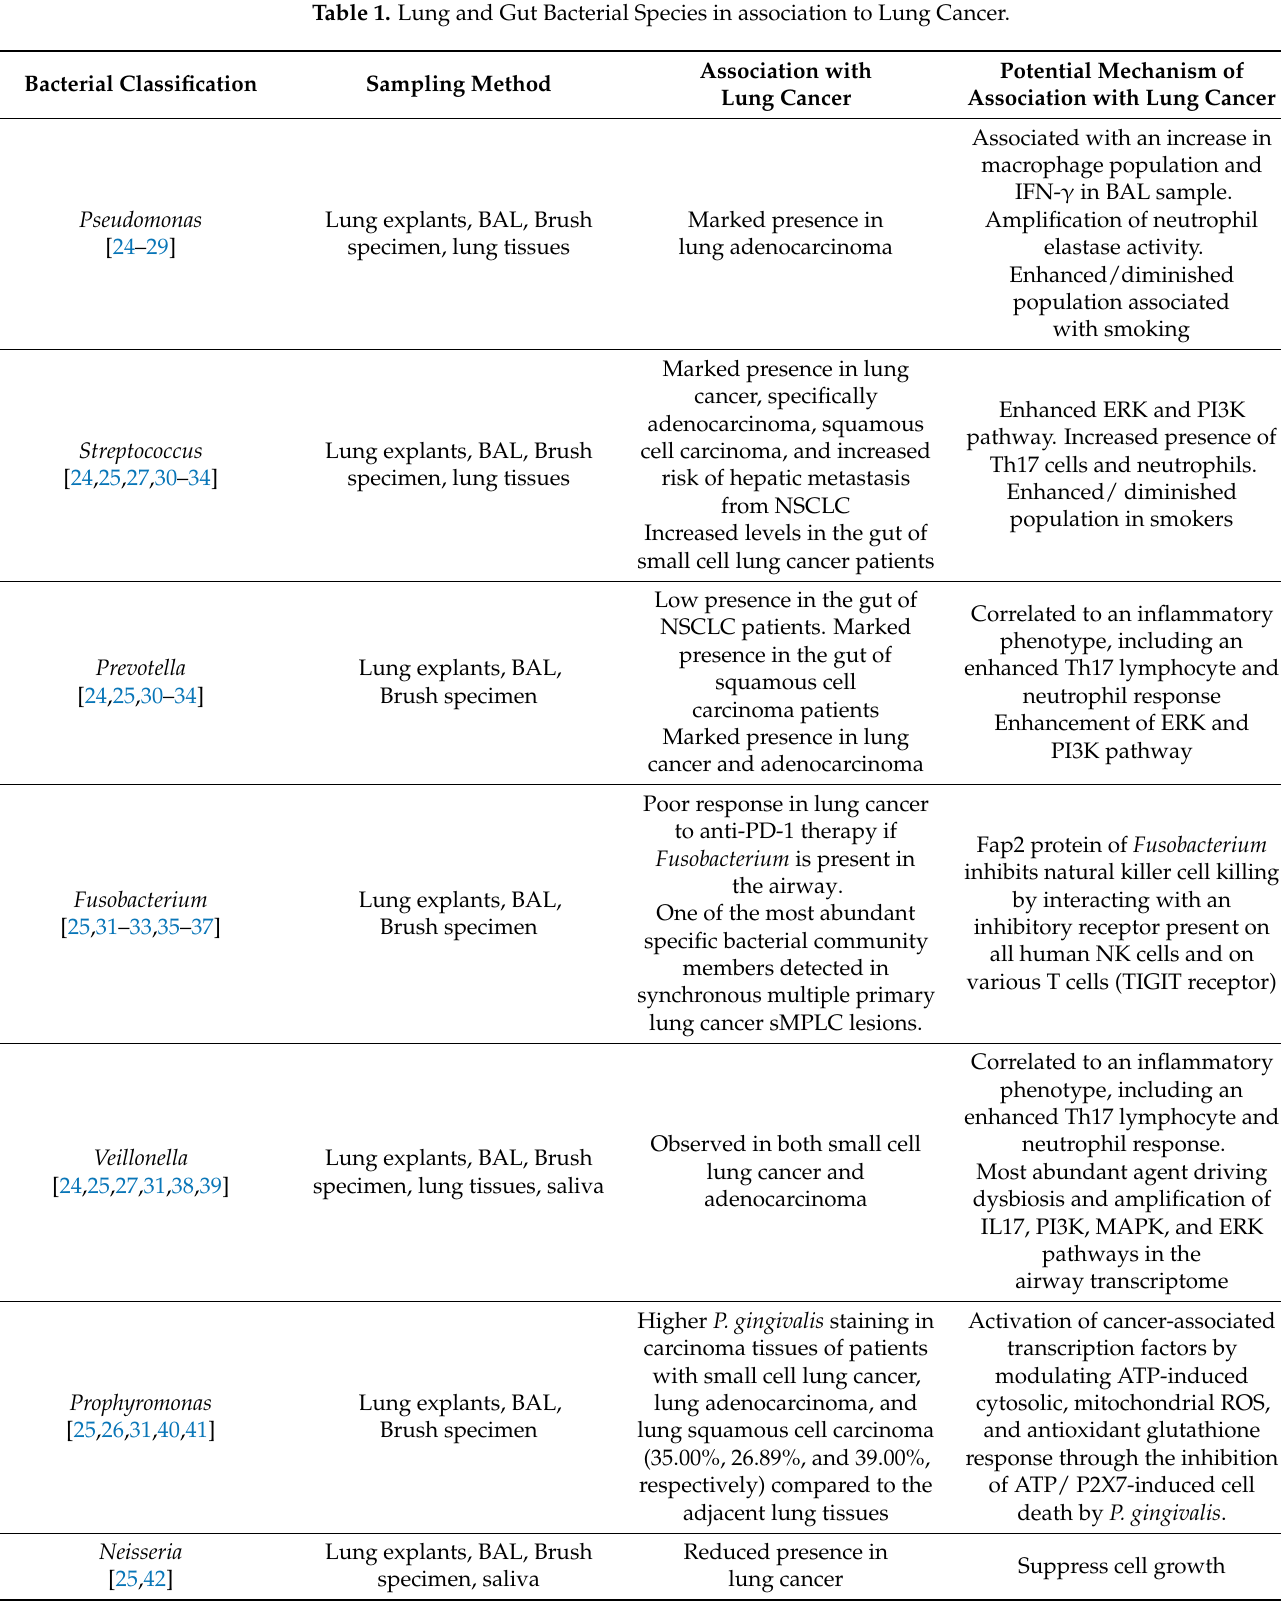
Table 1. Lung and Gut Bacterial Species in association to Lung